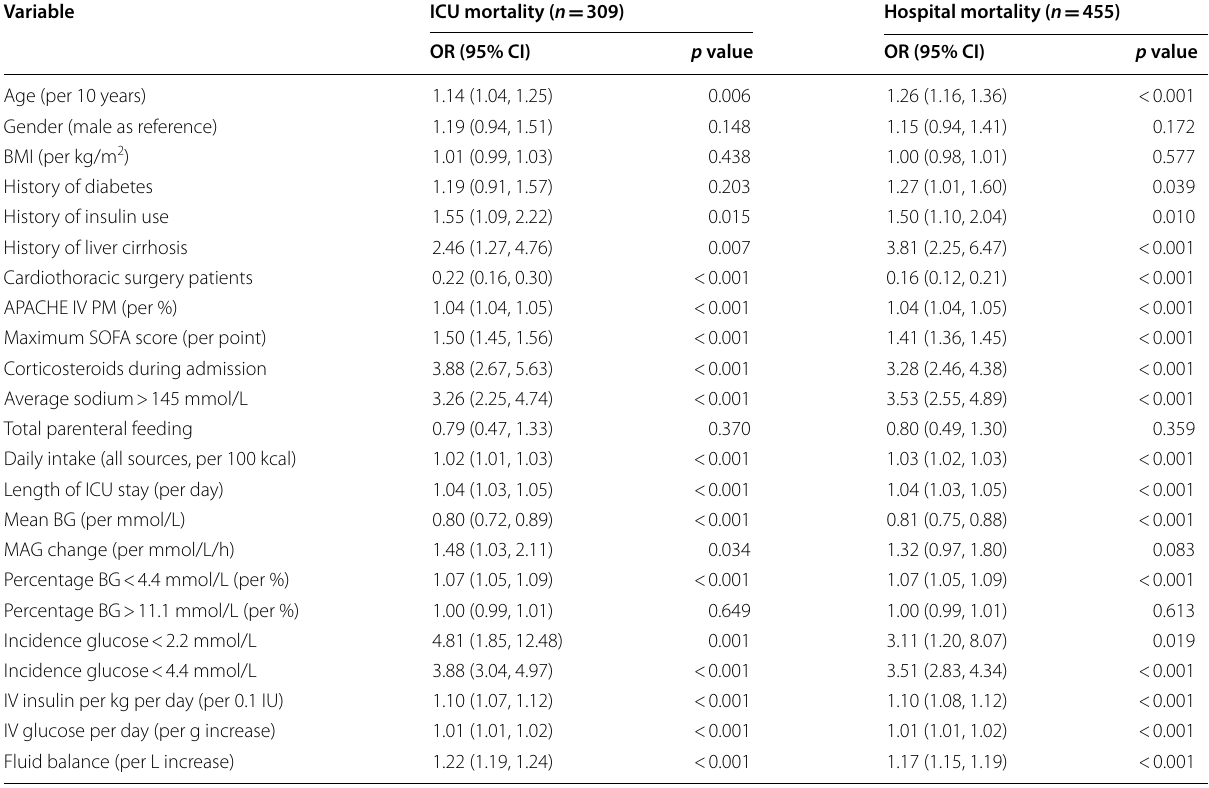
Table 2 Univariate logistic regression analysis for the association with ICU and hospital mortality in all included patients ( n 3966) =